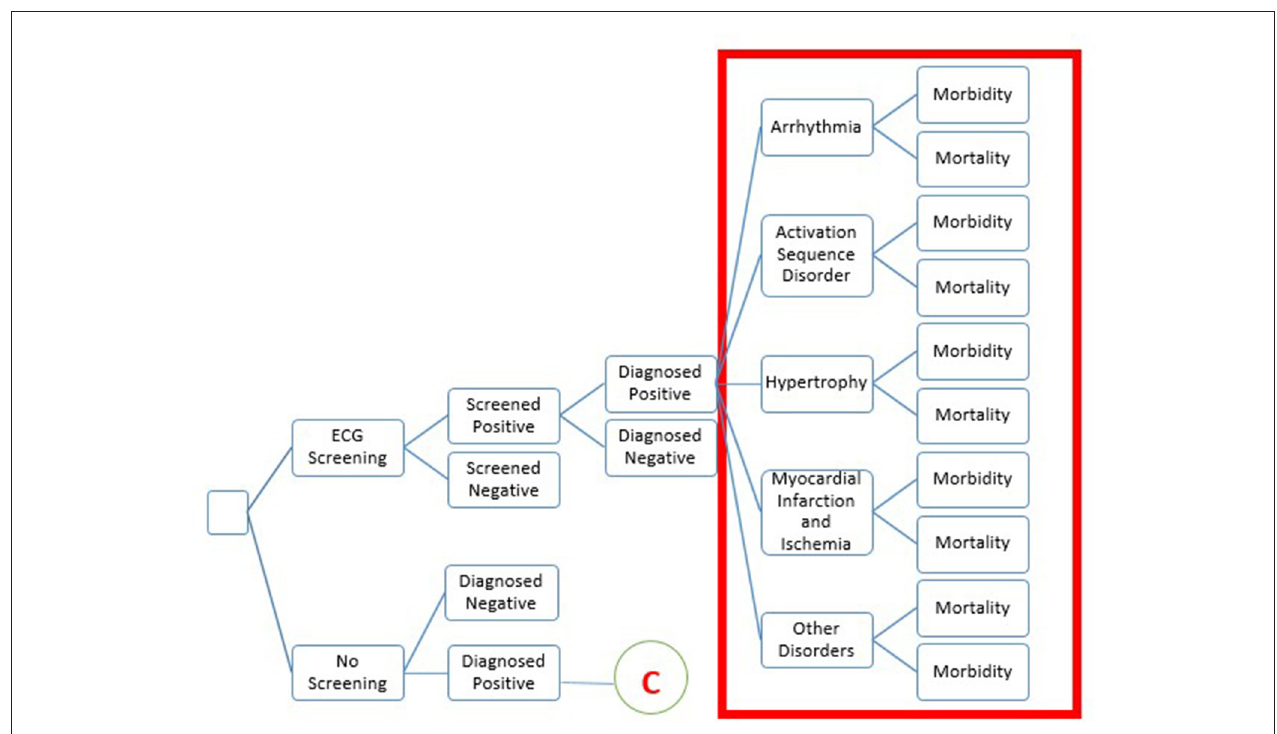
FIGURE 1 | The structure of decision-tree model. The decision tree describes the pathway of a patient presenting to primary care with signs or symptoms who will be screened using the ECG device. Diagnosed positive cases will be further classified into five sets of diseases. During this period, some patients will have a diagnosis and start treatment or die. The second arm, no screening will be considered to follow similar pathways for diagnosed positive.